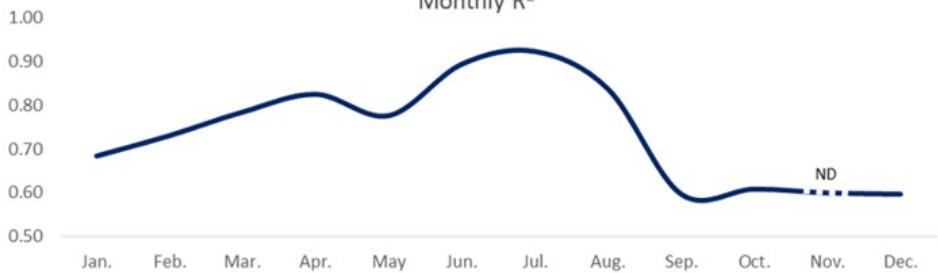
Figure 3. ( A ) Log-log plots of the relationship between monthly accommodation tax per county and the average of monthly non-resident Twitter users per county. ( B ) R 2 values of this relationship across year 2017.